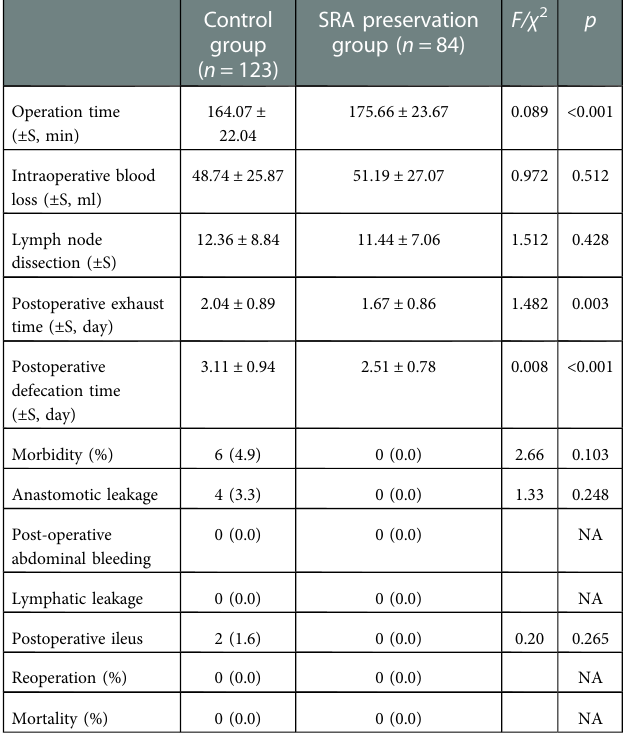
TABLE 2 Operation data, postoperative complications and mortality.